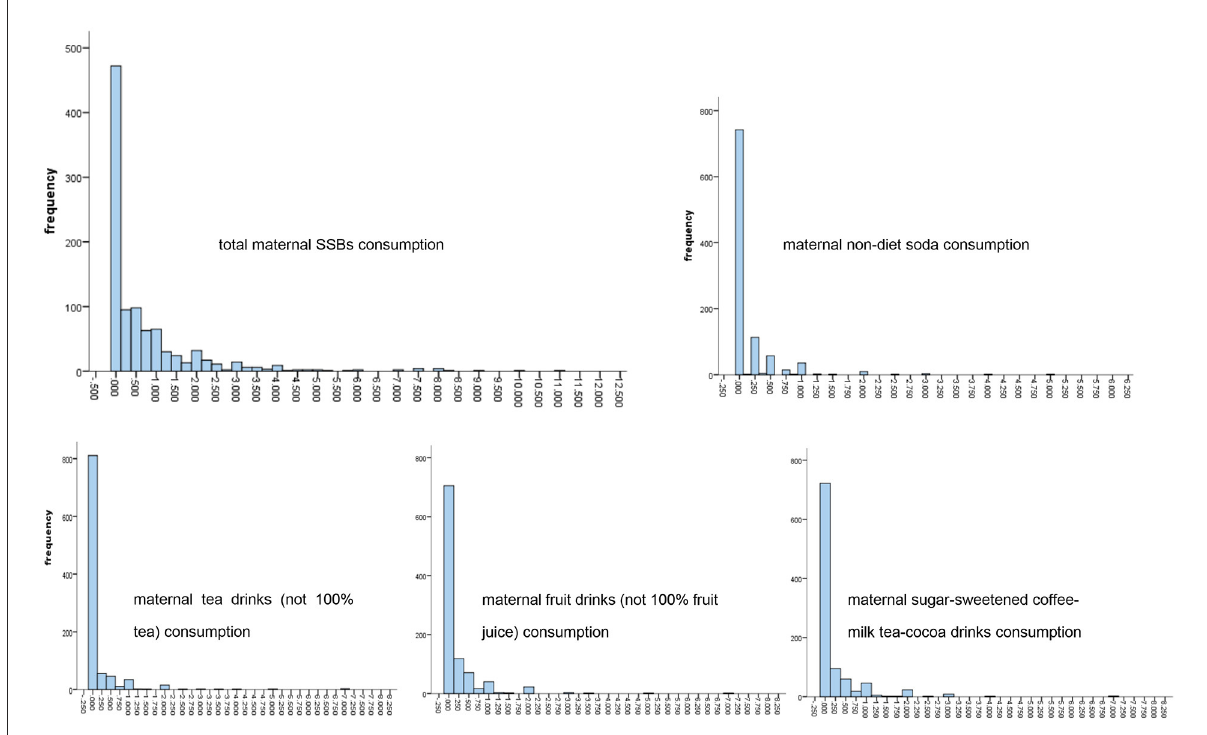
FIGURE1 Frequency distribution of maternal SSBs